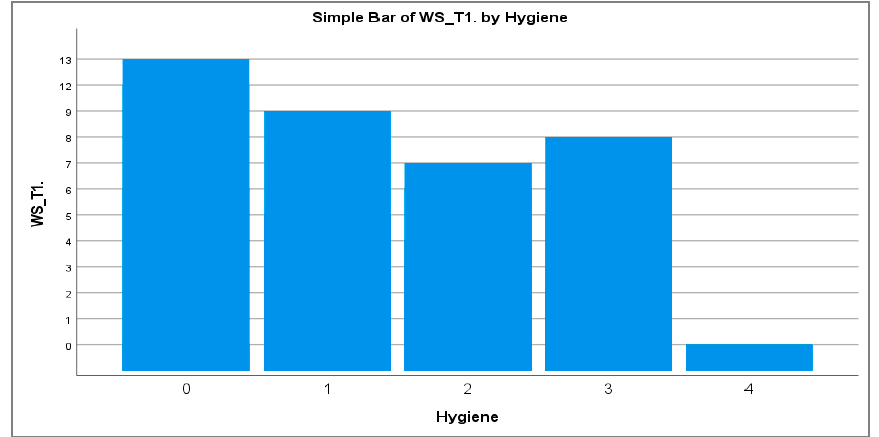
Figure 1. The association of tooth brushing frequency related with the WS number at